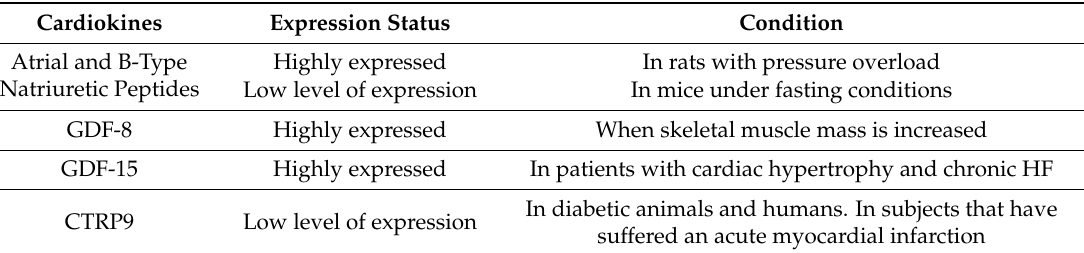
Table 1. Cardiokines as potential CVD